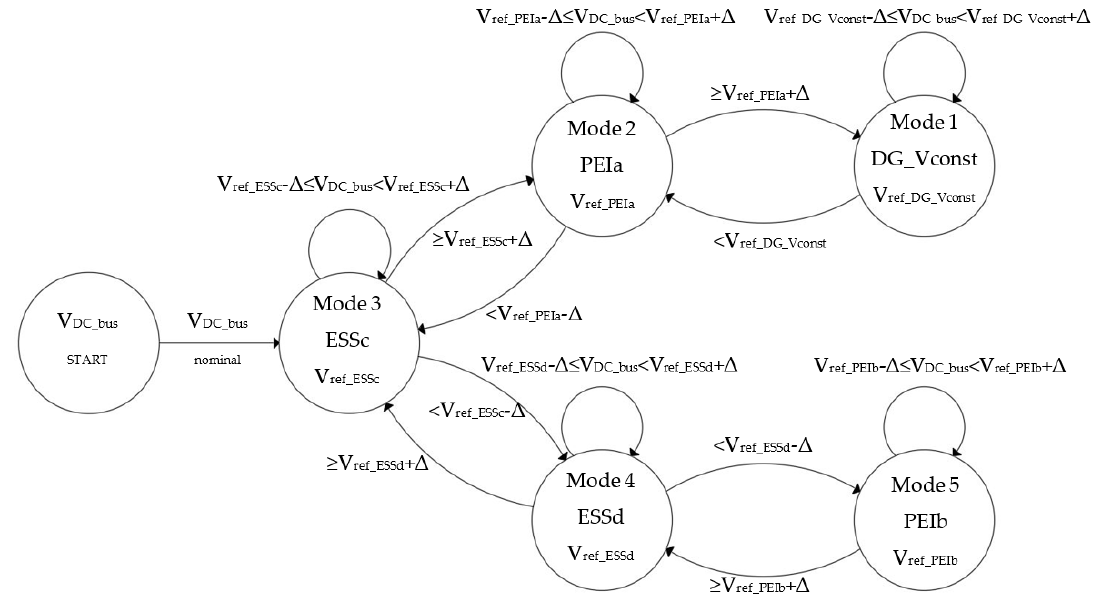
Figure 4. SUN operation modes and transitions between them.